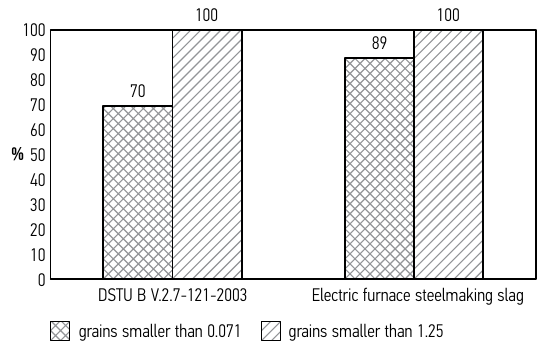
Fig. 4. Content of particles [% of mass] according to the Ukrainian Standard DSTU B